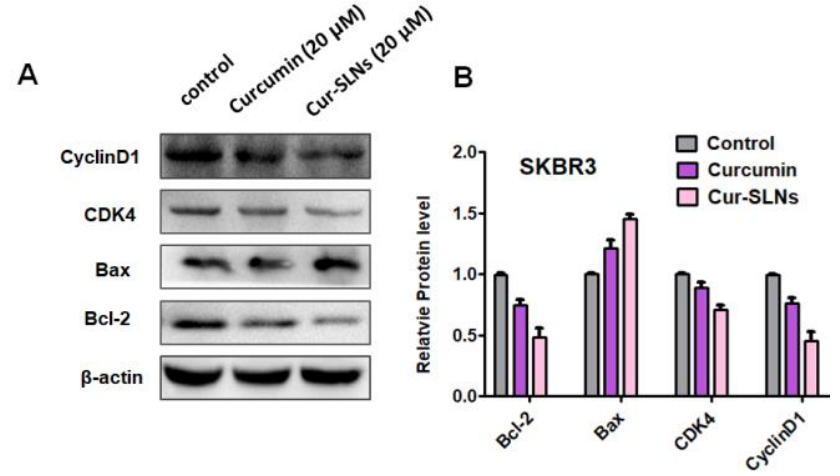
Figure 7. ( A ) The protein expression levels of Bcl-2, Bax, CDK4 , and cyclin D1 . β -Actin was used as a loading control. ( B ) Quantification of levels of the abovementioned proteins, normalized to the internal control ( n = 3 per group, mean ± SD).